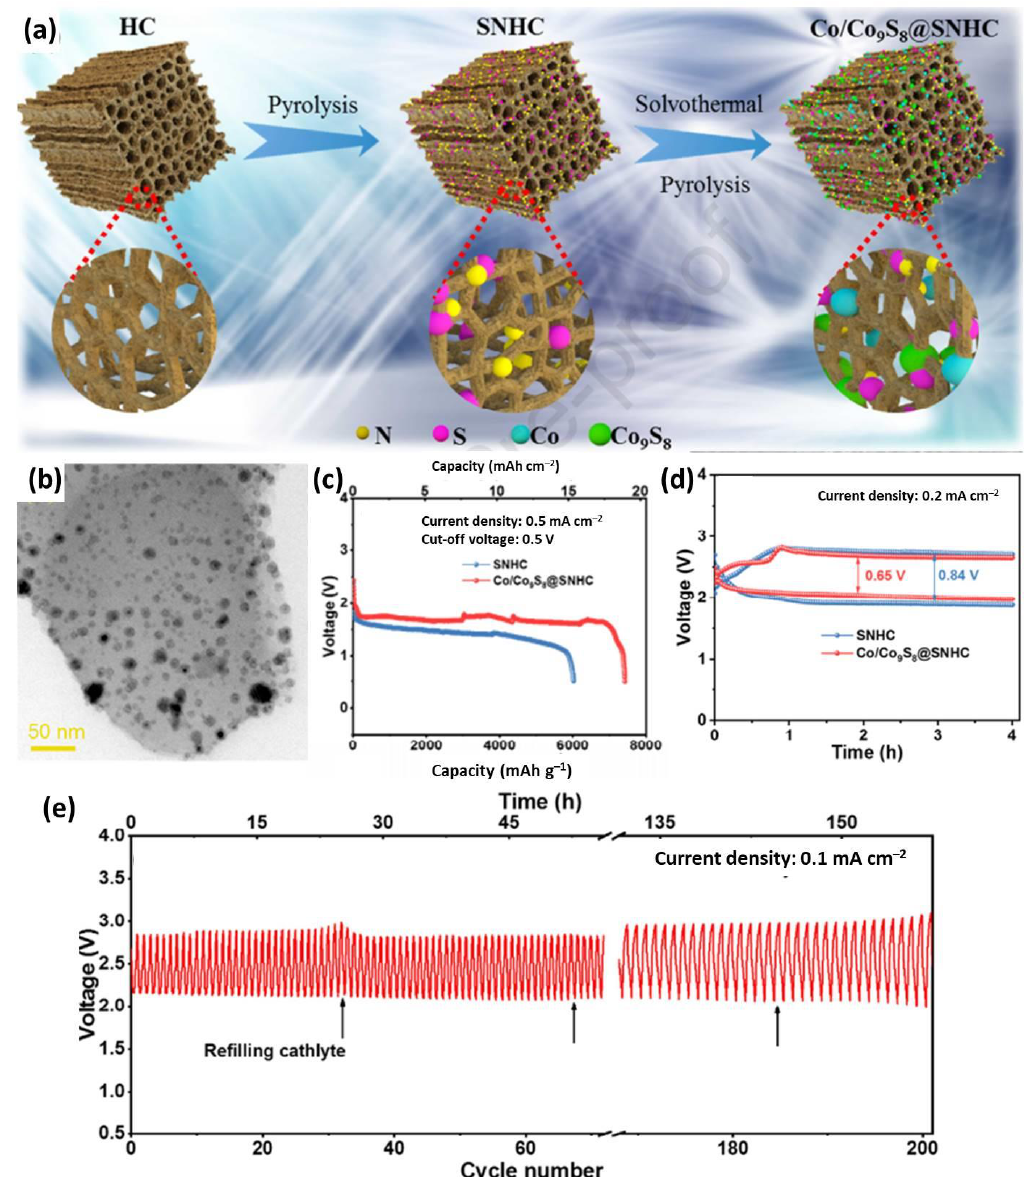
Figure 7. ( a ) Schematic illustration of synthesis procedures for Co/Co 9 S 8 @SNHC; ( b ) TEM images of Co/Co 9 S 8 @SNHC; ( c ) Discharge capacity of Na-CO 2 batteries with Co/Co 9 S 8 @SNHC or SNHC; ( d ) Discharge–charge curves at a current density of 0.2 mA cm –2 of Na-CO 2 batteries with Co/Co 9 S 8 @SNHC or SNHC; ( e ) Cycling performance of Na-CO 2 battery with Co/Co 9 S 8 @SNHC as the catalyst. Reproduced with permission from [67]. Copyright 2021, Elsevier.